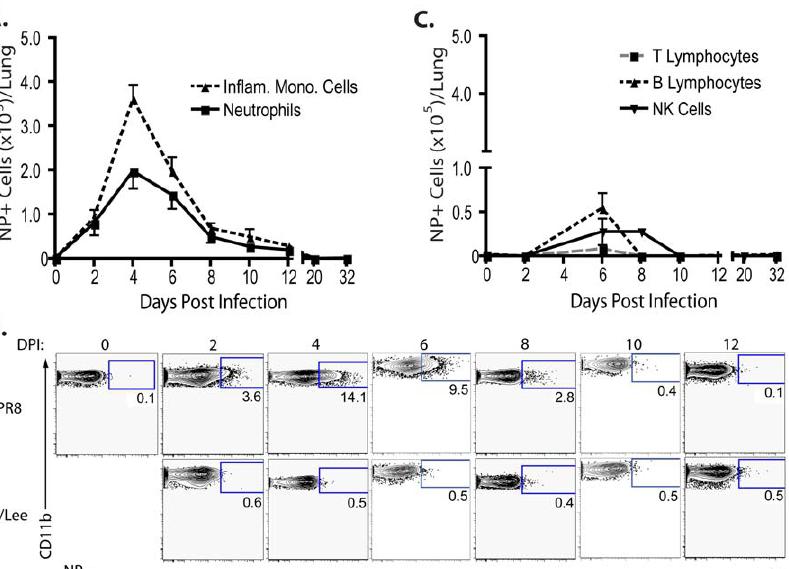
Figure 2. Hematopoietic cell influenza nucleocapsid protein content during an influenza virus infection. ( A–C ) BALB/c mice were infected with PR8 (0.1LD 50 ) i.n.. ( A ) Absolute numbers of NP + neutrophils (solid line) and NP + inflammatory mononuclear cells (dashed line) infiltrating the respiratory tract over time. ( B ) Representative flow cytometry panels depicting influenza NP expression in the lung neutrophil population during the course of an influenza virus infection. Neutrophils from PR8 (top panels) or B/Lee (bottom panels) infected mice are depicted. ( C ) Absolute numbers of NP + lymphocytes (T cells – gray dashes; B cells – black dashes; NK cells – solid lines) infiltrating the respiratory tract over time. ( A–C ) Cells from B/Lee infected mice (at corresponding day p.i.) were utilized to set flow cytometric gate due to the inability of the a NP to recognize B/Lee NP. Two independent experiments (n=2–4/expt) represented as mean 6 SEM where applicable.